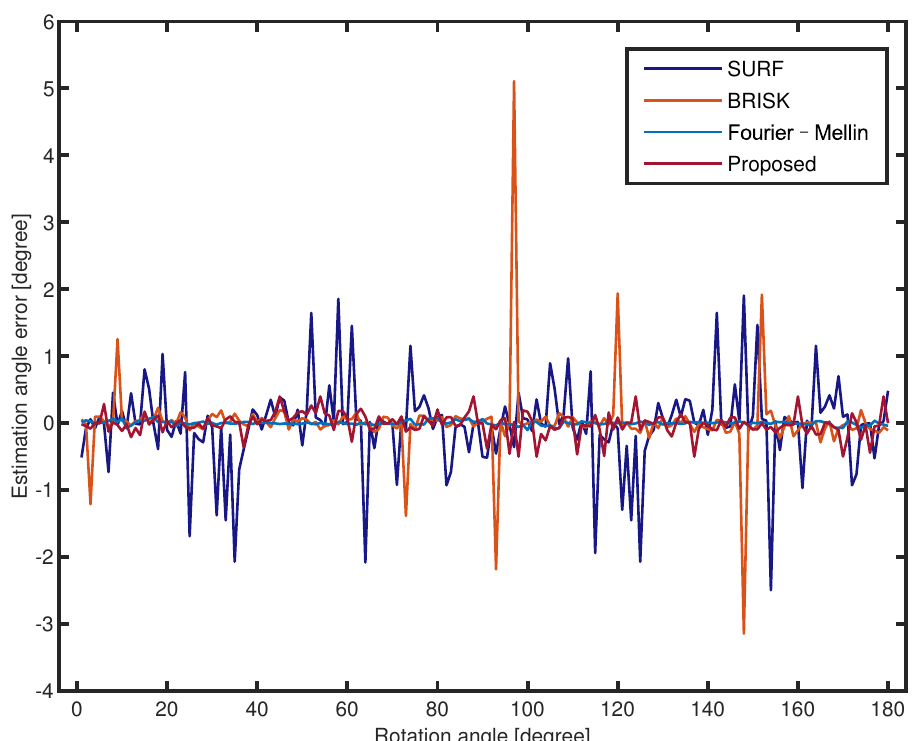
Figure 6. Rotation estimation errors for all rotation angles of the Lena image with no noise (scale 0.8).